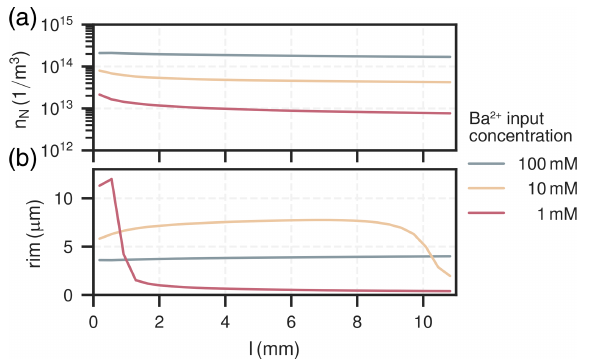
Figure 4. Spatial distribution of nuclei (a) and their corresponding rim thickness (b) in the column for all experiments.